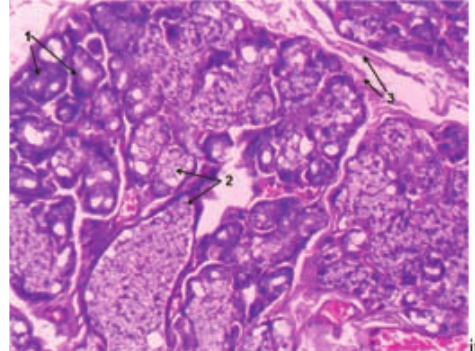
Fig. 2 Photomicrograph of oral mucosal sample from canine to third premolar in dogs showing minor salivary glands. H and E x 150. (1) Serous glands, (2) Mucus glands, (3). Connective tissue septa